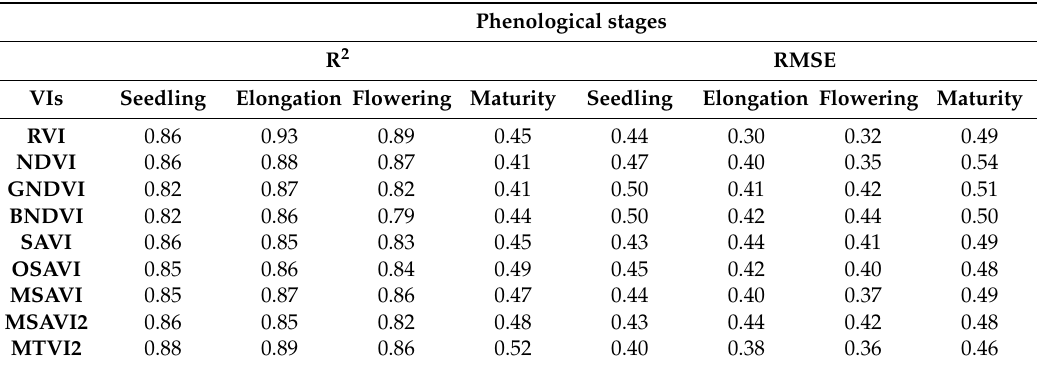
Table 3. Relationship of spectral VIs at the di ff erent phenological